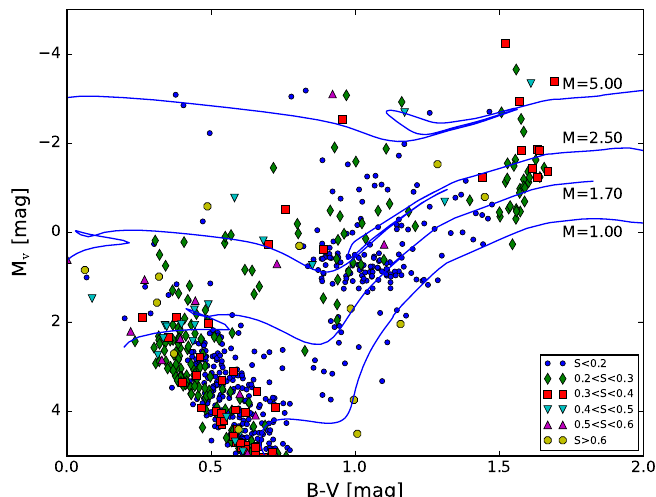
Figure 1. Mount Wilson S-indices of Duncan et al., 1991 [41] of giants in the HR diagramme show the well-known increase on the lower RGB (after crossing the Hertzsprung gap), but also on the upper AGB, part of which is due to better contrast against the photospheric Ca II lines, and in part this is an increase in chromospheric emission in real terms—courtesy of MNRAS and Schröder et al., 2018